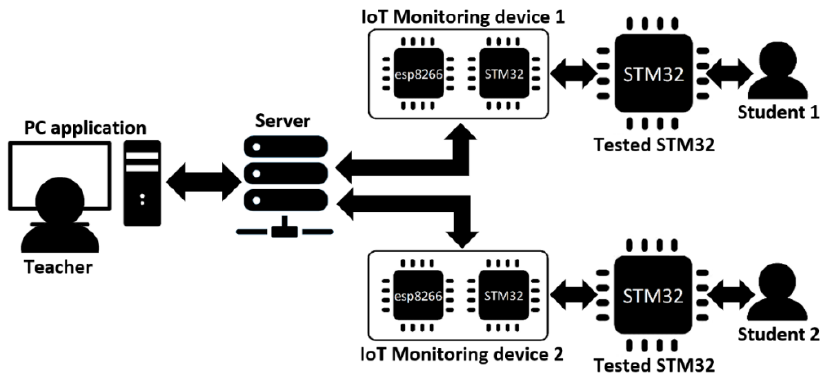
Figure 2. The IoT remote laboratory design in blocks.